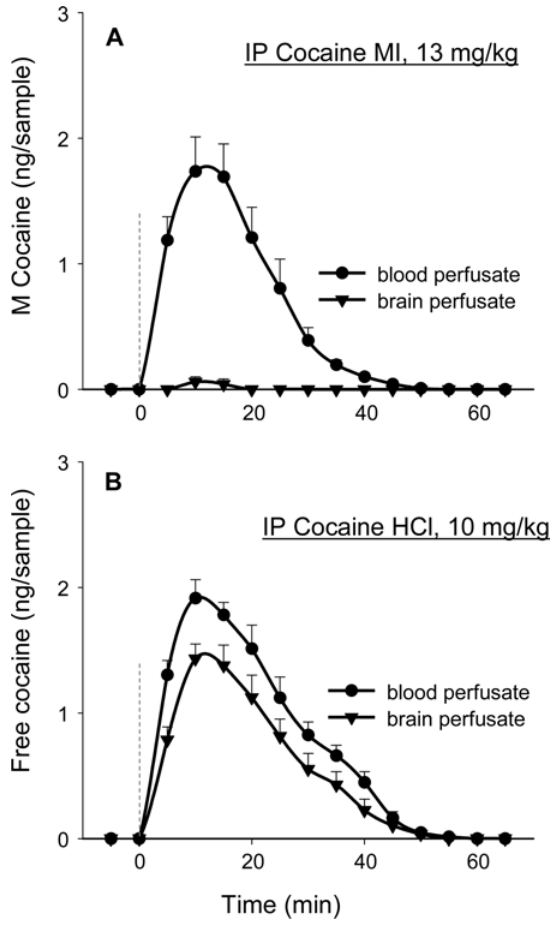
Figure 3. Levels of free and methylated cocaine (M Cocaine) in blood and brain following IP injections of cocaine MI (13 mg/ kg) (top panel) or cocaine HCl (10 mg/kg) (bottom panel). Cocaine HCl dissociates at physiological pH and free cocaine enters the brain readily. The methyl group does not dissociate readily from cocaine MI at physiological pH, and the methylated quaternary salt does not cross the blood brain barrier.